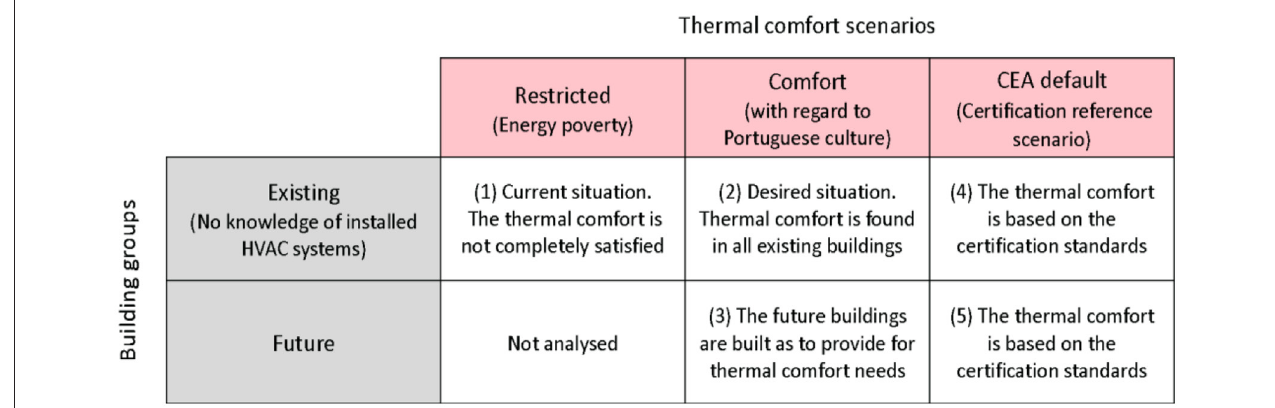
FIGURE 3 | Building stock and thermal comfort scenarios’ overview.